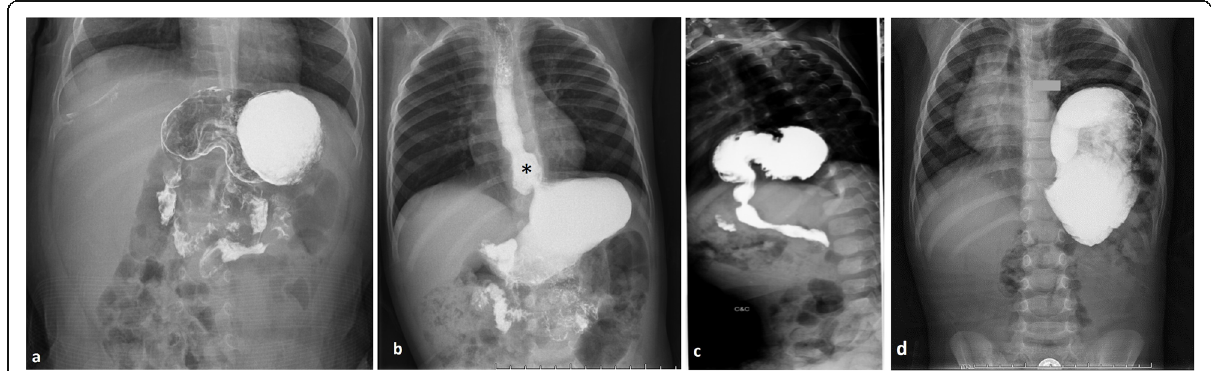
Fig. 2 Different patterns of gastric abnormalities. a Gastric organoaxial volvulus. b Sliding hiatus hernia (asterisk) with dilated esophagus. c Large hiatus hernia containing most of the stomach associated with volvulus. d Left-sided Bochdalek hernia containing the stomach and other bowel loops